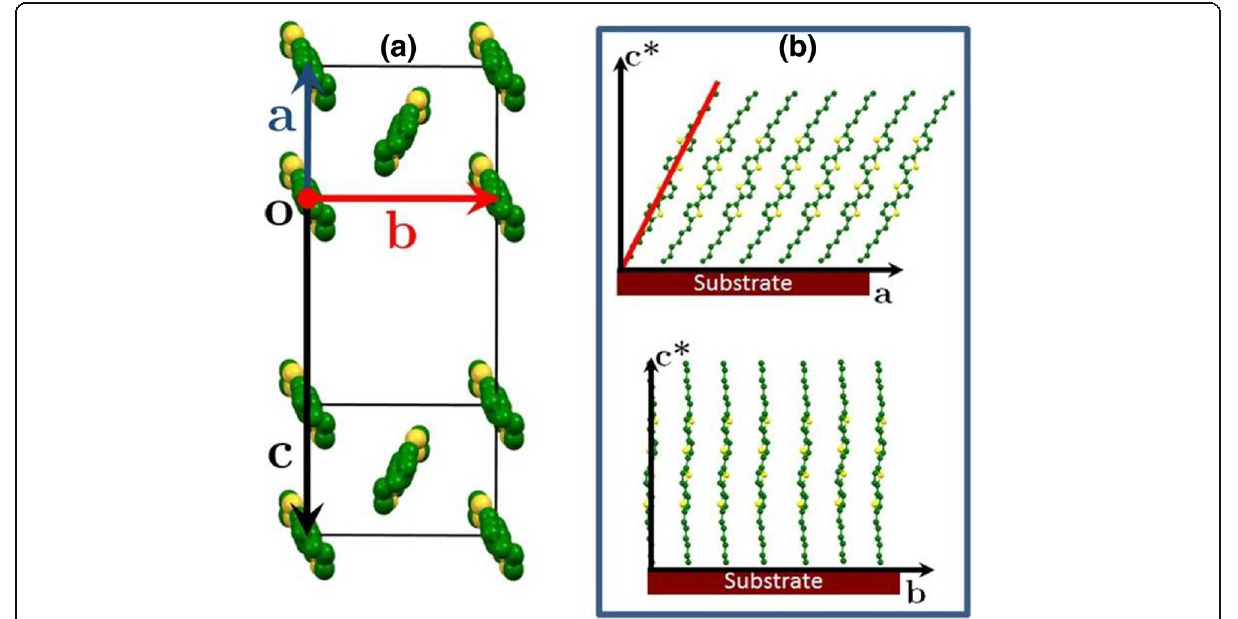
Fig. 2. a Unit cell structure of the DH4T compound in the low-temperature crystalline phase viewed along the molecular direction and b orientation of the molecules with respect to the substrate